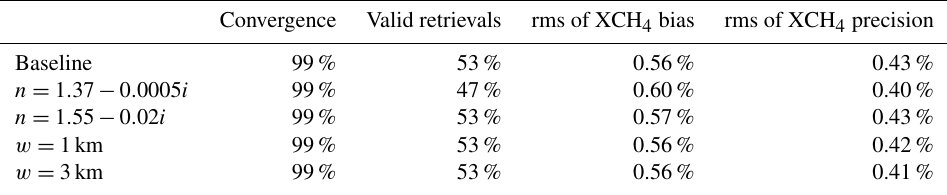
Table A1. Effect of fixed-value aerosol parameters on convergence rate, fraction of valid retrievals after filtering and rms values of XCH 4 bias and precision for the global ensemble. See text for values used in the baseline run.